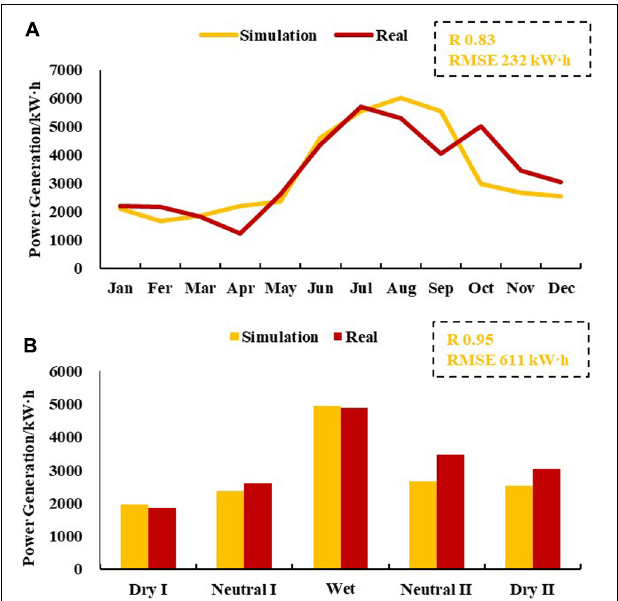
FIGURE 10 | Simulation power generation compare with actual power generation: (A) monthly power generation; (B) power generation in